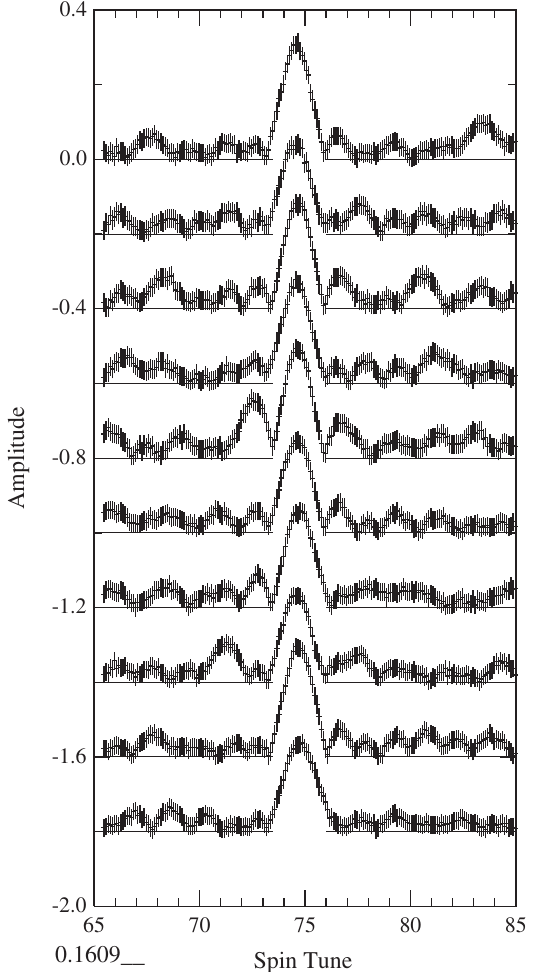
FIG. 5. Values of the magnitude of a fit of Eq. (3) to a set of events collected during successive 4-s time bins during one machine cycle time as a function of the spin tune ν S . Each successive time bin is plotted with a zero line that is shifted down by 0.2. The peak center represents the best choice of spin tune for each time bin. The typical FWHM of the peak is 1 . 7 × 10 − 6 or 10 ppm. For simplicity, the first four digits of each value on the horizontal axis are noted in the lower-left corner. The value at the center of the axis is 0.160975.